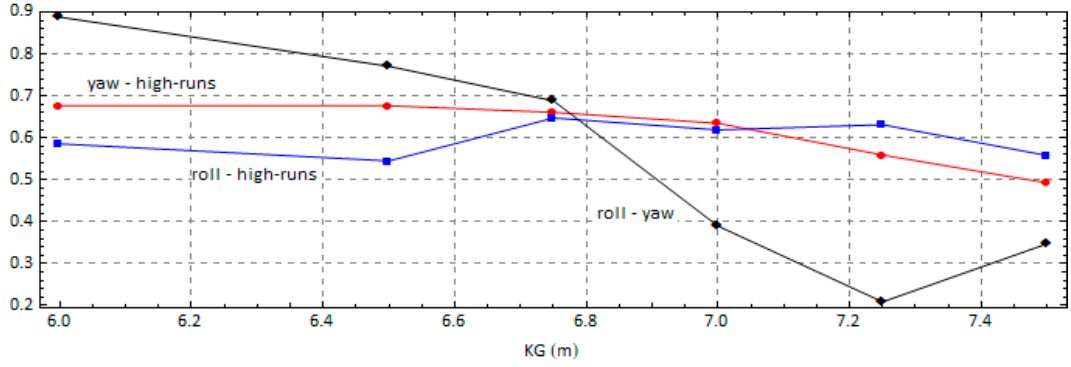
Figure 19. Effect of the KG on the indices of concurrence. Figure 19. E ff ect of the KG on the indices of